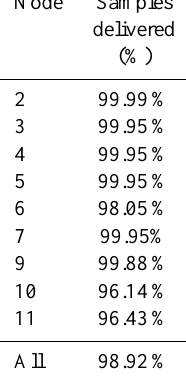
Table 5. Samples